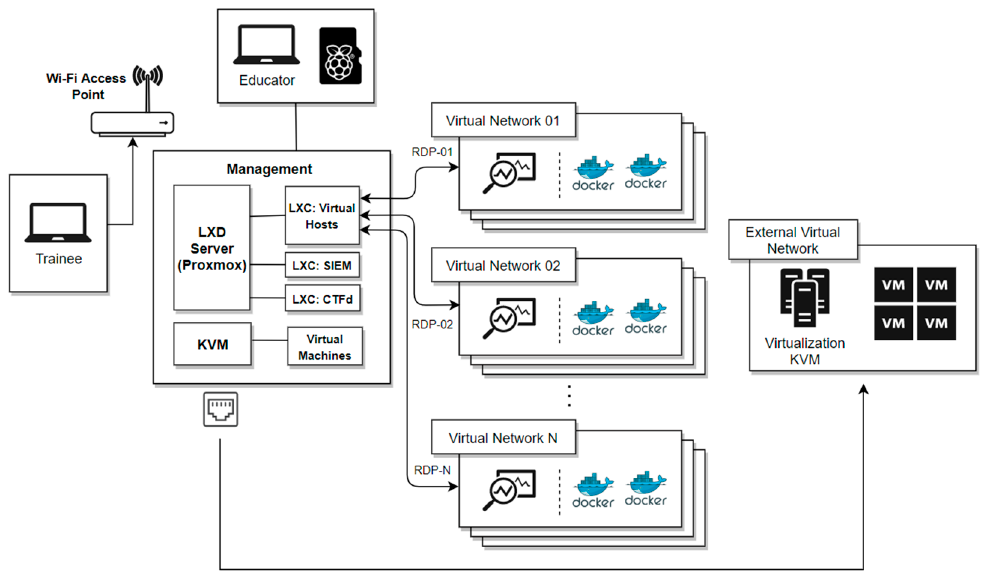
Figure 1. Software architecture of PocketCTF .